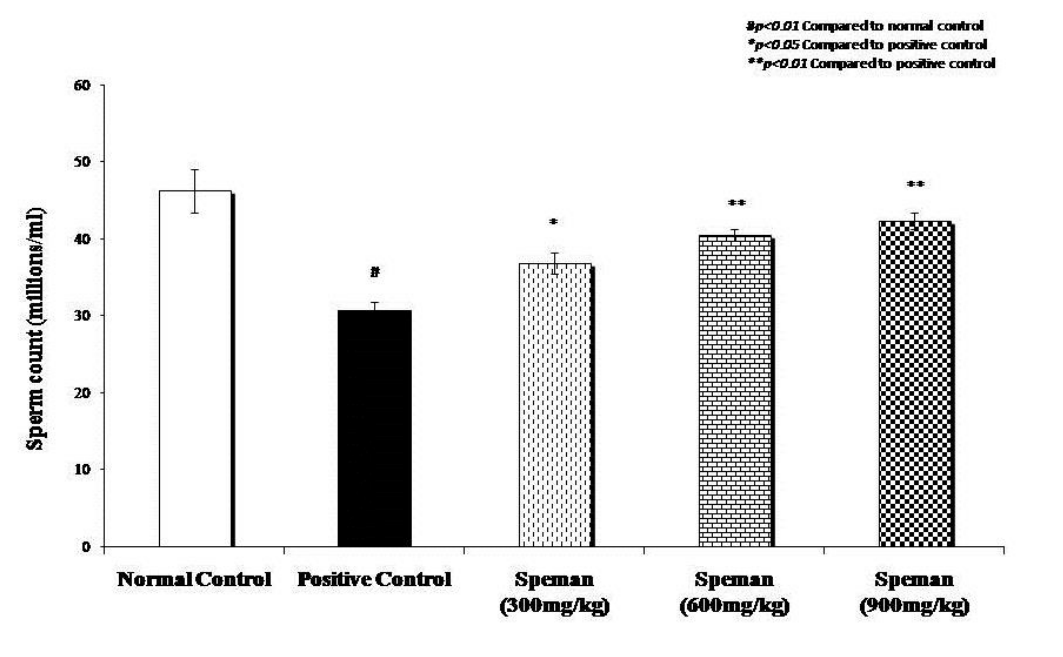
Figure 1: Effect of Speman ® on sperm count in an experimental model of CP-induced oligospermia in